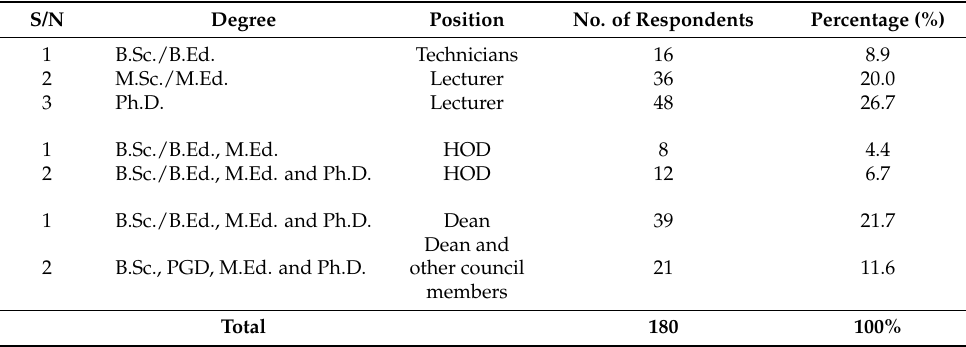
Table 1. Principal administrators and technical staff that impact e-learning in the tertiary institutions used in the